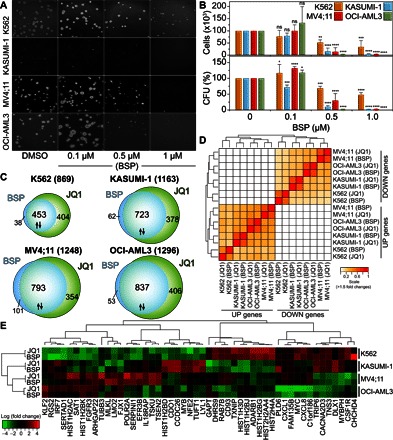
BSP inhibits growth in leukemia cell lines.(A) BSP inhibits clonogenic growth in leukemia cell lines. K562, KASUMI-1, MV4;11, and OCI-AML3 in methylcellulose were treated with vehicle (DMSO) or BSP (0.1, 0.5, or 1 μM) (n = 4). (B) Colony formation assay in K562, KASUMI-1, MV4;11, and OCI-AML3 cells using 0.1, 0.5, or 1.0 μM BSP (top) and the number of cells counted after treatment of cells with BSP for 6 to 10 days (n = 4) (bottom). CFU, colony-forming units; ns, not significant. (C) Similarity comparison of significantly expressed genes (P < 0.001 and fold change > 1.5) in the four cell lines after drug treatment. The heat map represents the intersect matrix for all pairwise comparisons (cell lines and treatments) using euclidean distances and complete linkage after transformation of the intersect counts into similarity Jaccard measures. (D) Venn diagrams showing overlap of the top statistically significant (Benjamini-Hochberg adjusted P < 0.001) genes (up- or down-regulated with a fold change of >1.5) differentially expressed by BSP or the pan-BET inhibitor JQ1 in four leukemia cell lines (K562, KASUMI-1, OCI-AML3, and MV4;11) after 8 hours of treatment with the inhibitor (0.5 μM) (top) and breakdown of the expression in terms of up- and down-regulated genes for each cell line (bottom). (E) Heat map of log fold changes in the expression of the top 50 statistically significant genes in the four cell lines tested, identified using Benjamini-Hochberg adjusted P < 0.001. Data in (B) represent means ± SEM (n = 4) and are annotated with P values obtained from a two-tailed t test (*P < 0.05, **P < 0.01, ***P < 0.001, and ****P < 0.0001).